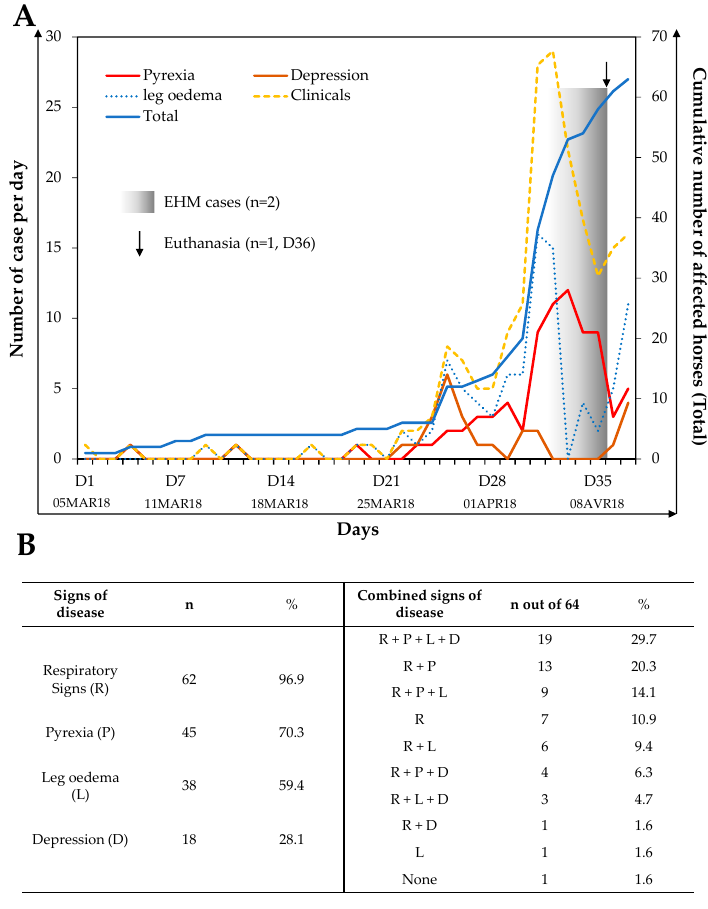
Figure 1. Clinical signs monitored from 5 March 2018 to 22 April 2018 in a group of 64 horses from a single stable block in the premises ( A ). The left axis represents the number of cases per day with pyrexia, depression, leg oedema or general clinical signs; the right axis represents the total number of horses a ff ected each day (blue line). Frequency of horses showing a sign of disease, alone or in combination, is presented in ( B ).